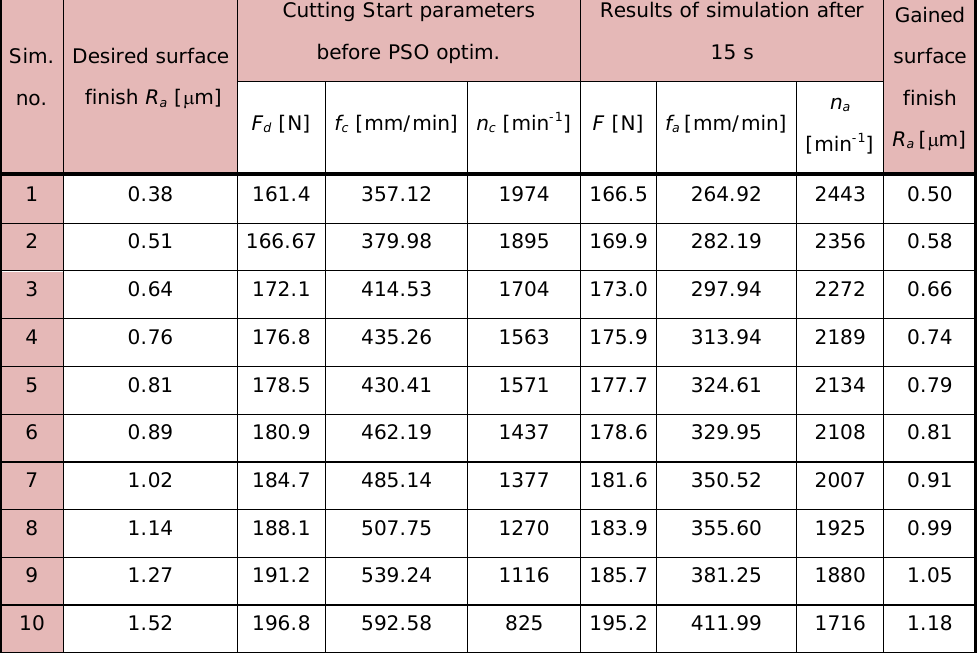
Table 2. “Results of the simulation”. Source: